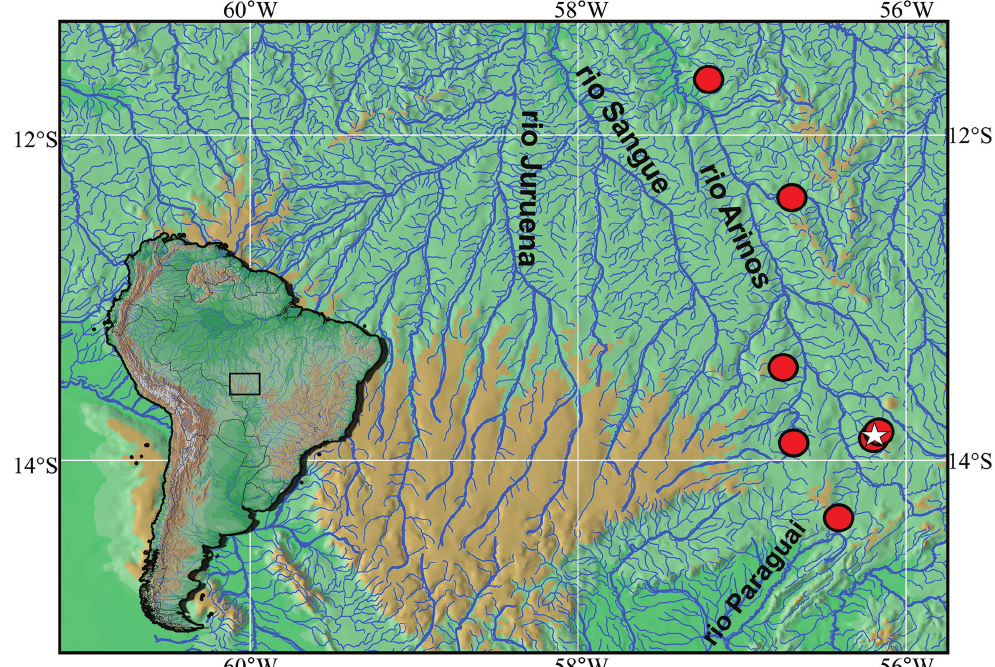
Fig. 2. Distribution map of Moenkhausia mutum in the upper rio Tapajós basin, Amazon basin. Type locality represented by white